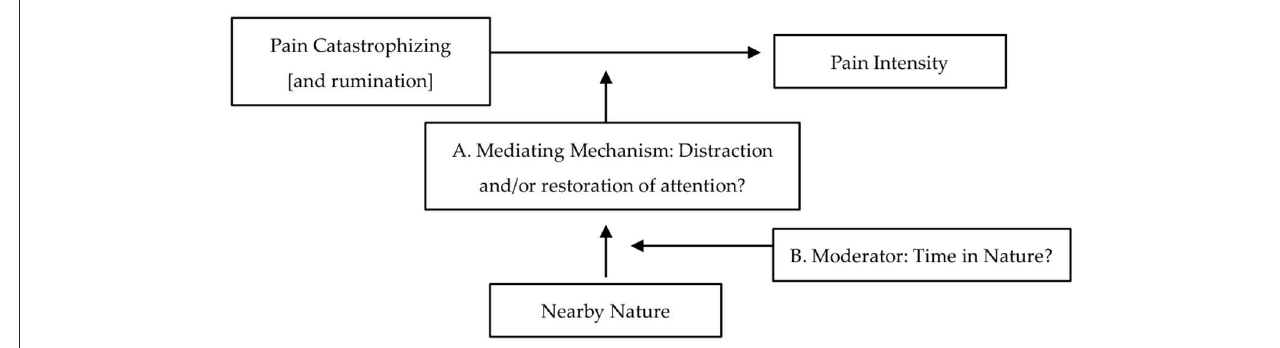
FIGURE 6 | Future research might examine: (A) what mediating mechanism underlies nearby nature’s buffering of the pain catastrophizing-pain intensity and rumination-pain intensity associations; and (B) the interaction of nearby nature and time in